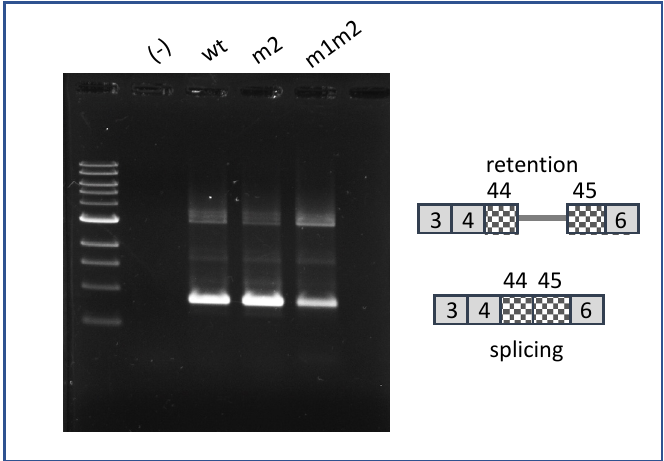
Figure 3. Effects of m2 mutations on IR. Lane (-), untransfected cells. Other lanes represent RT-PCR products from cells transfected with VWFwt, VWFm2, and VWFm1m2. Diagrams at right indicate the structures of the spliced products.